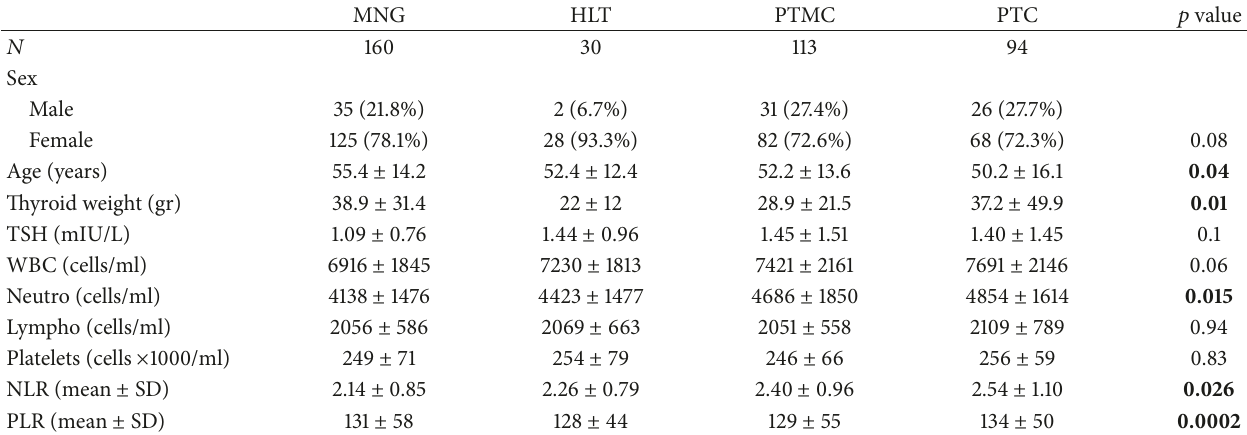
Table 2: Comparison of subgroups MNG, HLT, PTMC, and PTC.